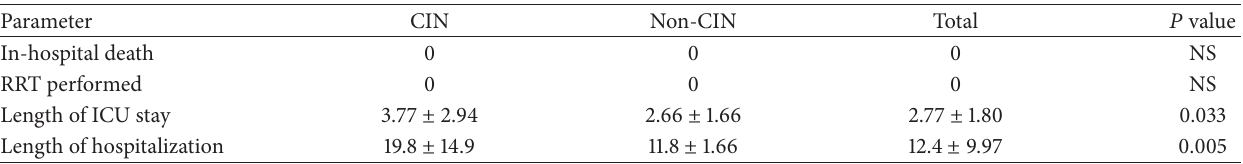
Table 3: Treatment outcomes.